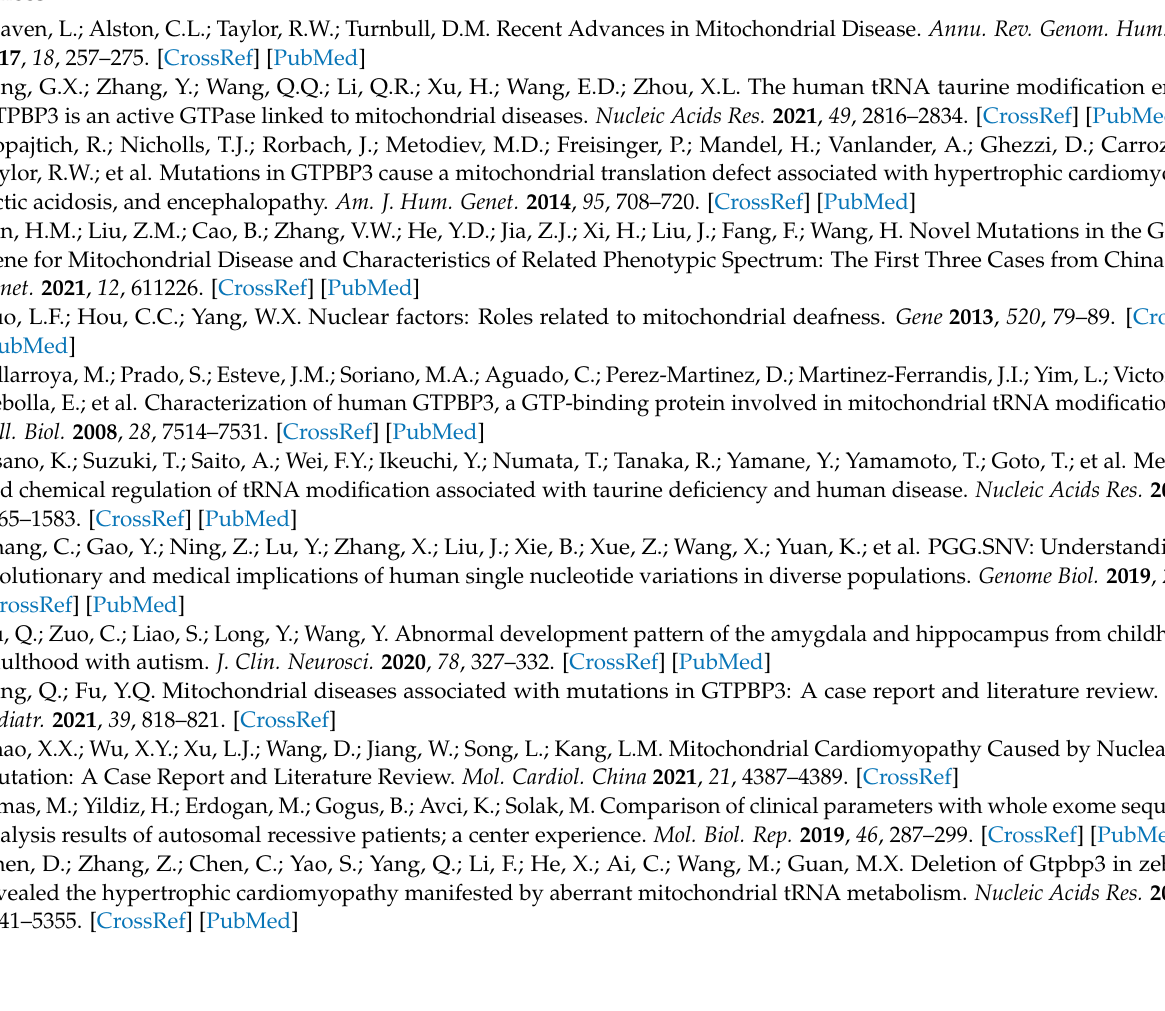
structural domains; Table S3: Distribution of variants in GTPBP3 from severe types and mild types across five structural